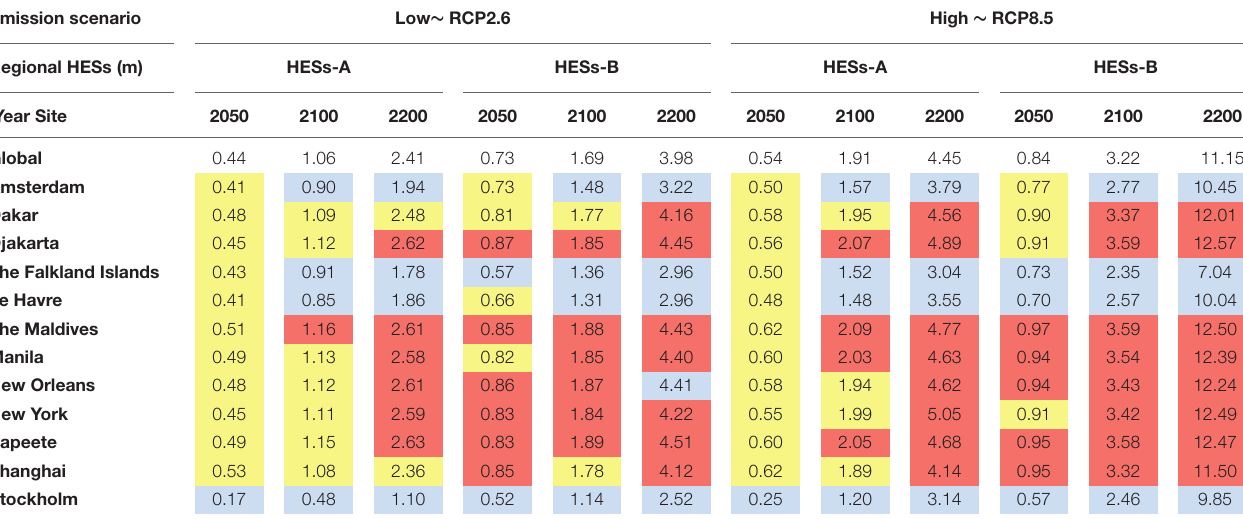
TABLE 3 | Regional HESs (m) for the selected sites given by HESs-A and HESs-B for each emission scenario and for each time horizons (2050, 2100, and 2200). Emission